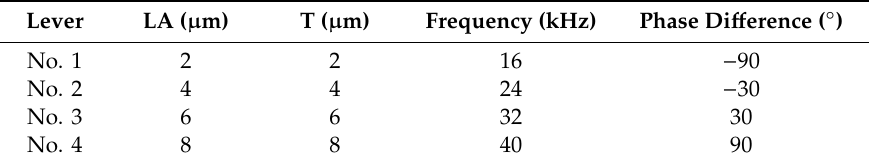
Table 6. Design for ultrasonic parameters L 16 (4 5